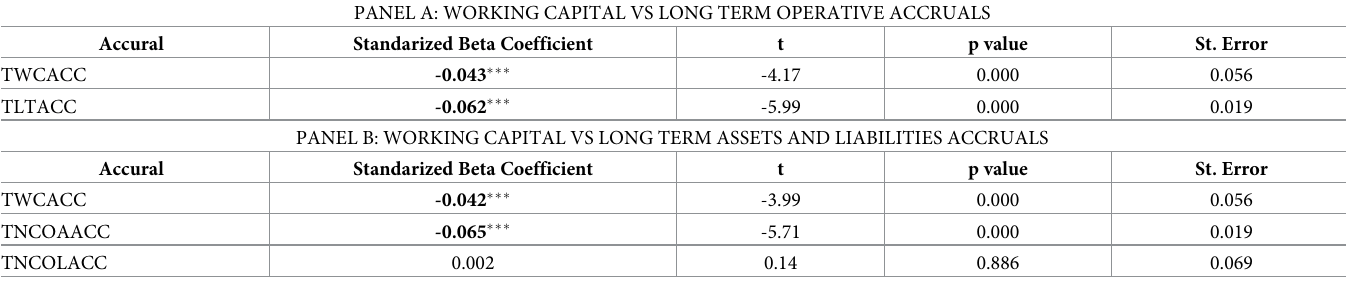
Table 4. Regreions model.